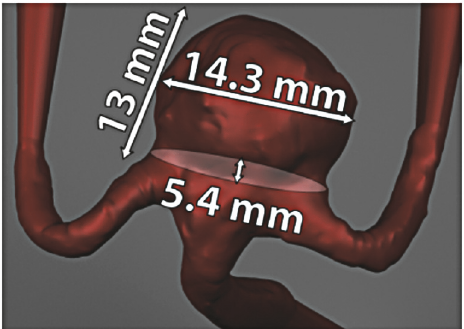
Figure 3: Dimensions of the aneurysm.